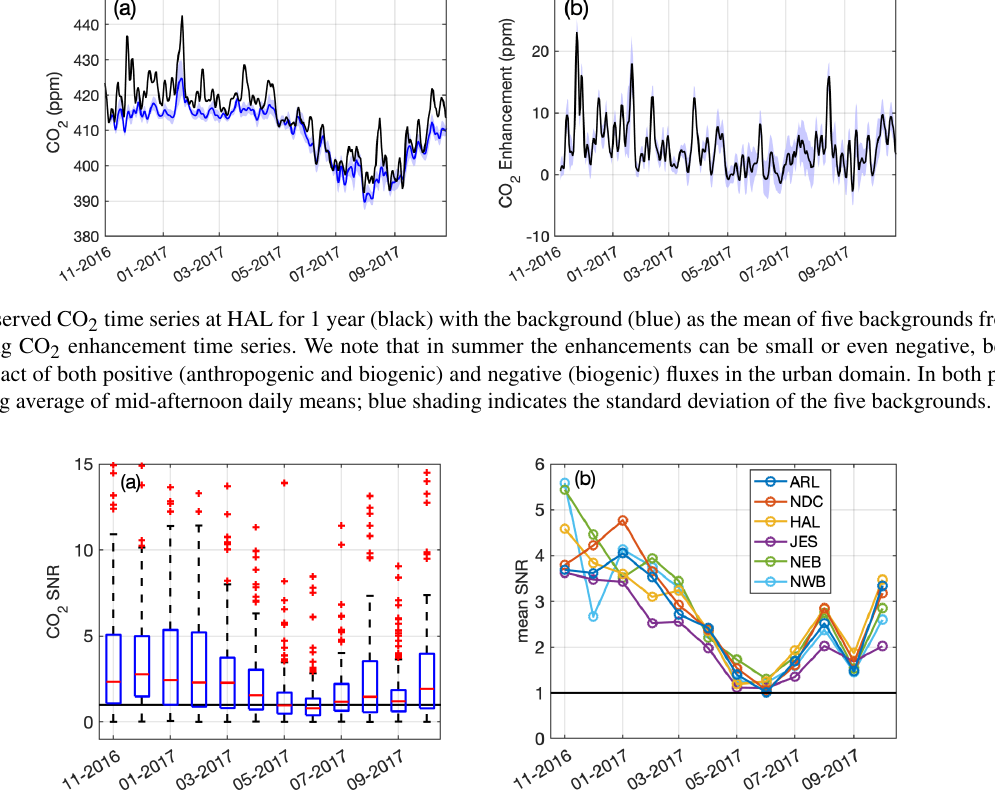
Figure 10. (a) Monthly box plot of the hourly signal-to-noise ratio (SNR) at all sites (afternoon hours only), calculated as the CO 2 enhance- ment ( y enh ) above the background divided by the standard deviation of the backgrounds (Fig. 8) for each hour. Red lines are medians; box edges indicate the 25th and 75th percentiles; whiskers indicate the extent excluding outliers, which are shown in red + marks. The y axis has been truncated for readability, so some outliers, up to 30, are not shown. (b) Average SNR by month for each site. Black solid line in both panels indicates SNR =